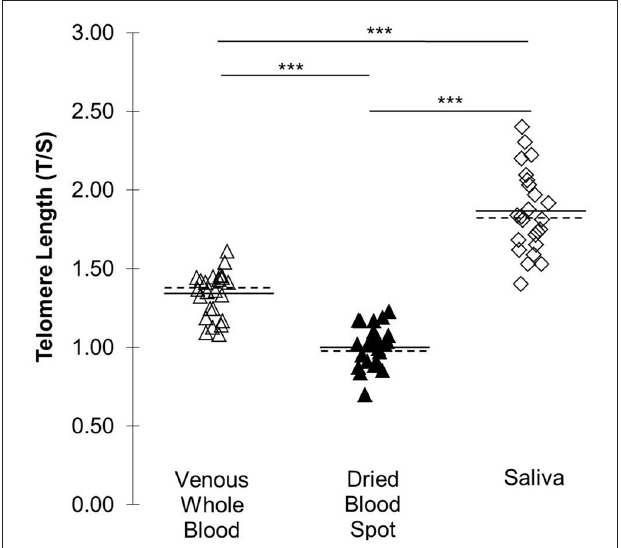
FIGURE 2 | TL (T/S) across three DNA collection methods. Solid lines indicate mean T/S by collection type. Dotted lines indicate median by collection type. ∗∗∗ p <